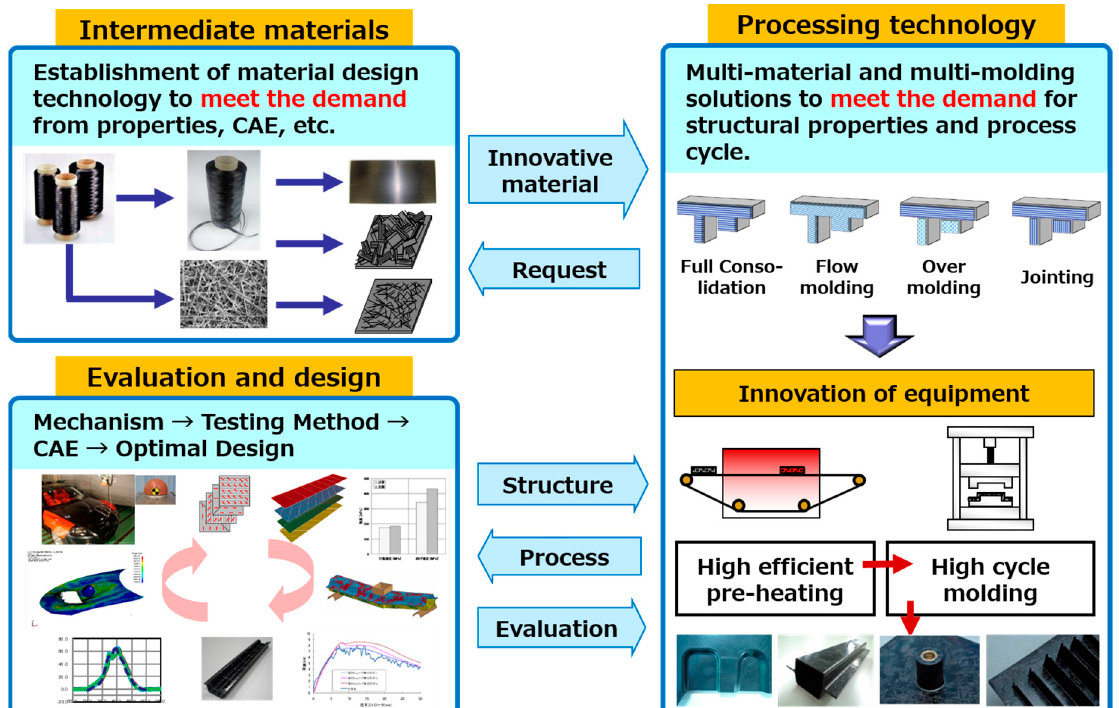
Figure 5. Research topics in the CFRTP projects.